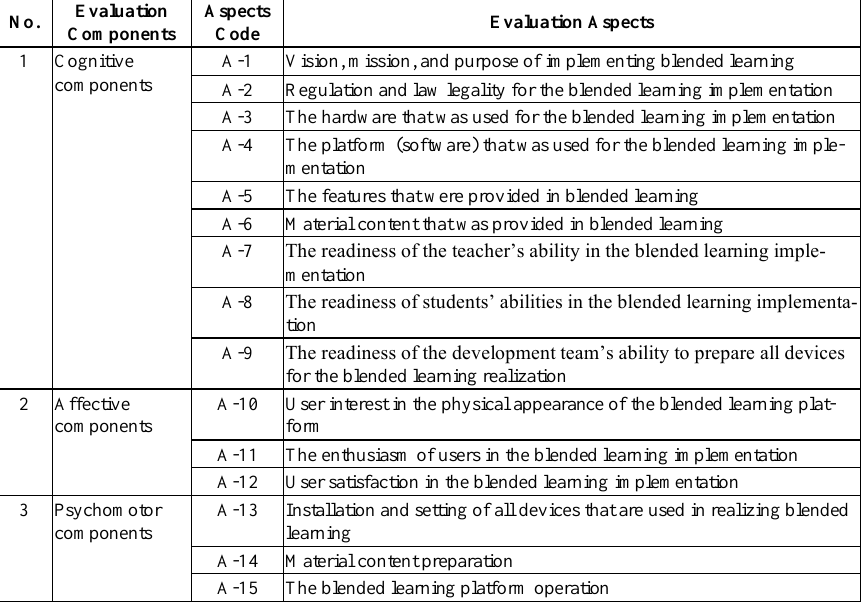
Table 2. Aspects of Evaluation on Evaluation Components that are Spread in the Description Evaluation Aspects No. Components Code